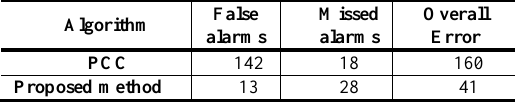
Table 6 . Change detection results by the two